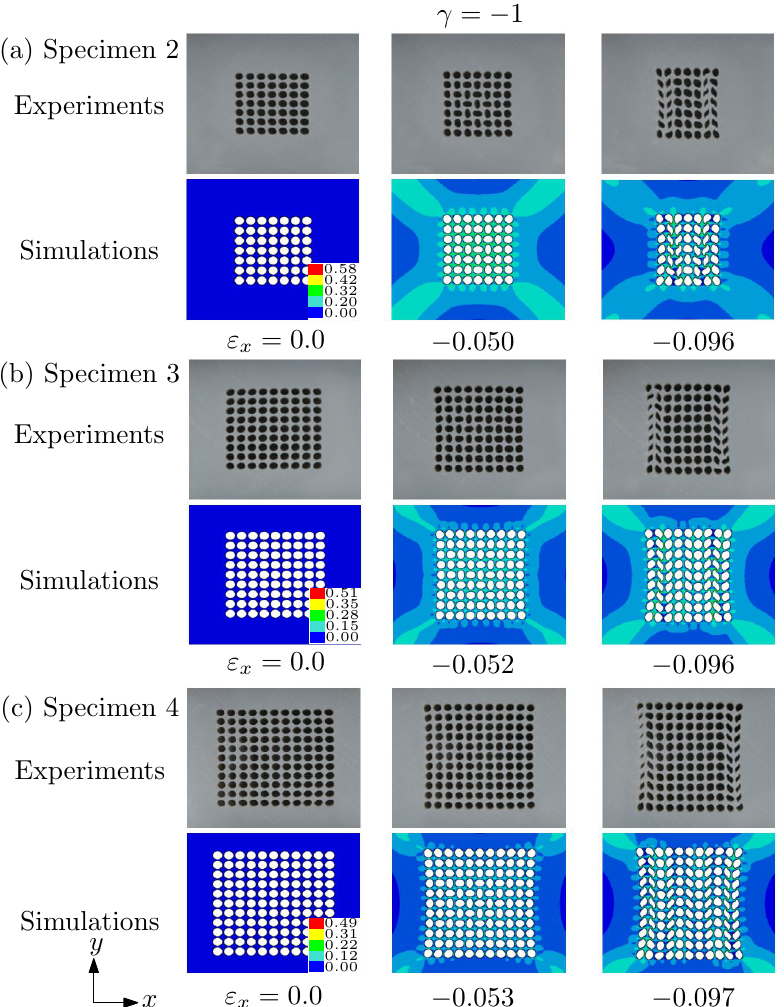
Figure 8. Deformed morphologies at different applied strains predicted by the simulations and the experiments. ( a ) Specimen 2; ( b ) specimen 3; ( c ) specimen 4. Under this biaxiality ratio γ = both pattern transformation I (alternating orthogonal elliptic voids) and pattern transformation II (chevron voids) could be observed. The color bar shows the effective strain of the